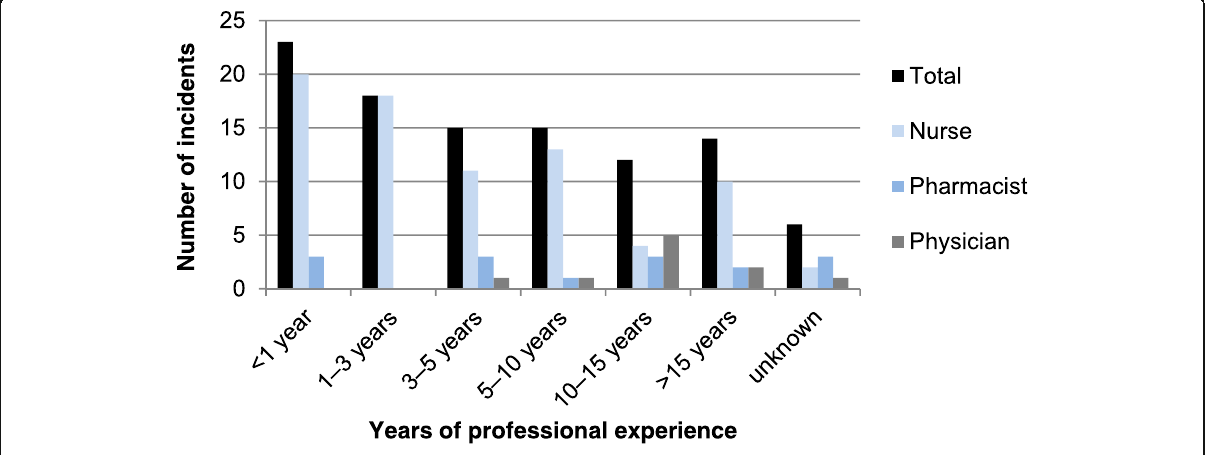
Fig. 2 Years of professional experience of the persons involved in the Kampo medicine-related incidents